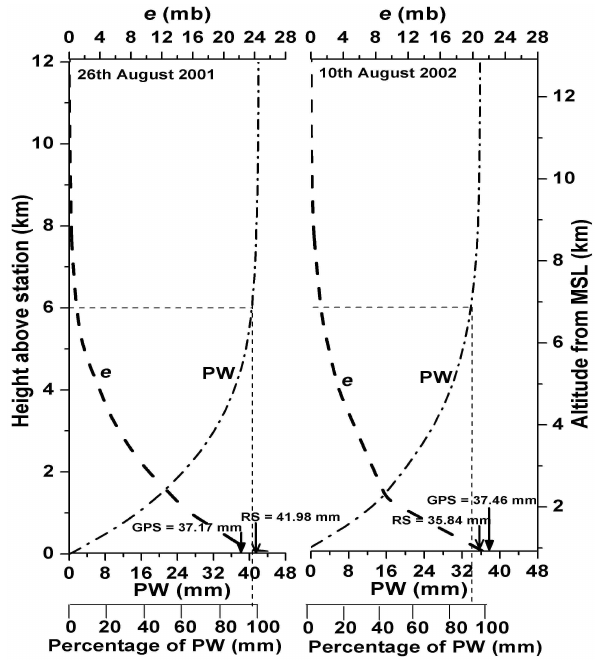
Figure 7 Fig. 7. Altitude profiles of water vapor partial pressure ( e ) from ra-